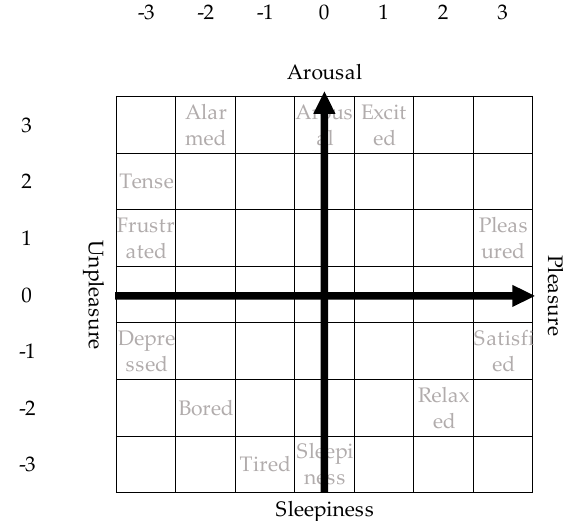
Figure 1. Task management using the prediction of pleasure, arousal, and engagement.